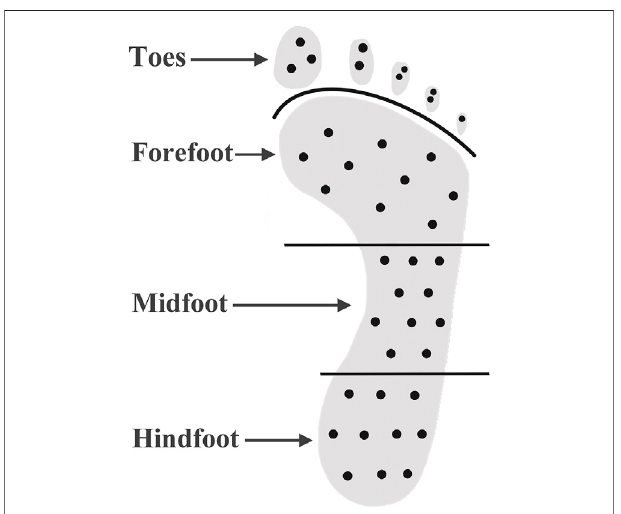
FIGURE 1 | Measurement of plantar soft tissue hardness by using the Shore (OO) durometer. The black dots indicate the measurement site of plantar tissue